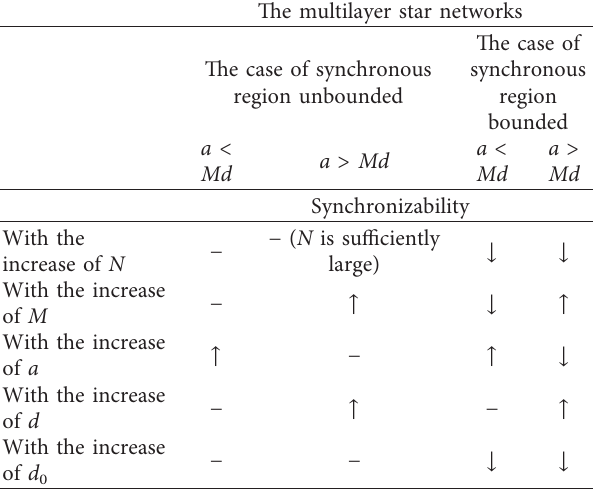
Table 2: When d � d , the synchronizability of the multilayer star 0 networks varies with N , a , d , and M